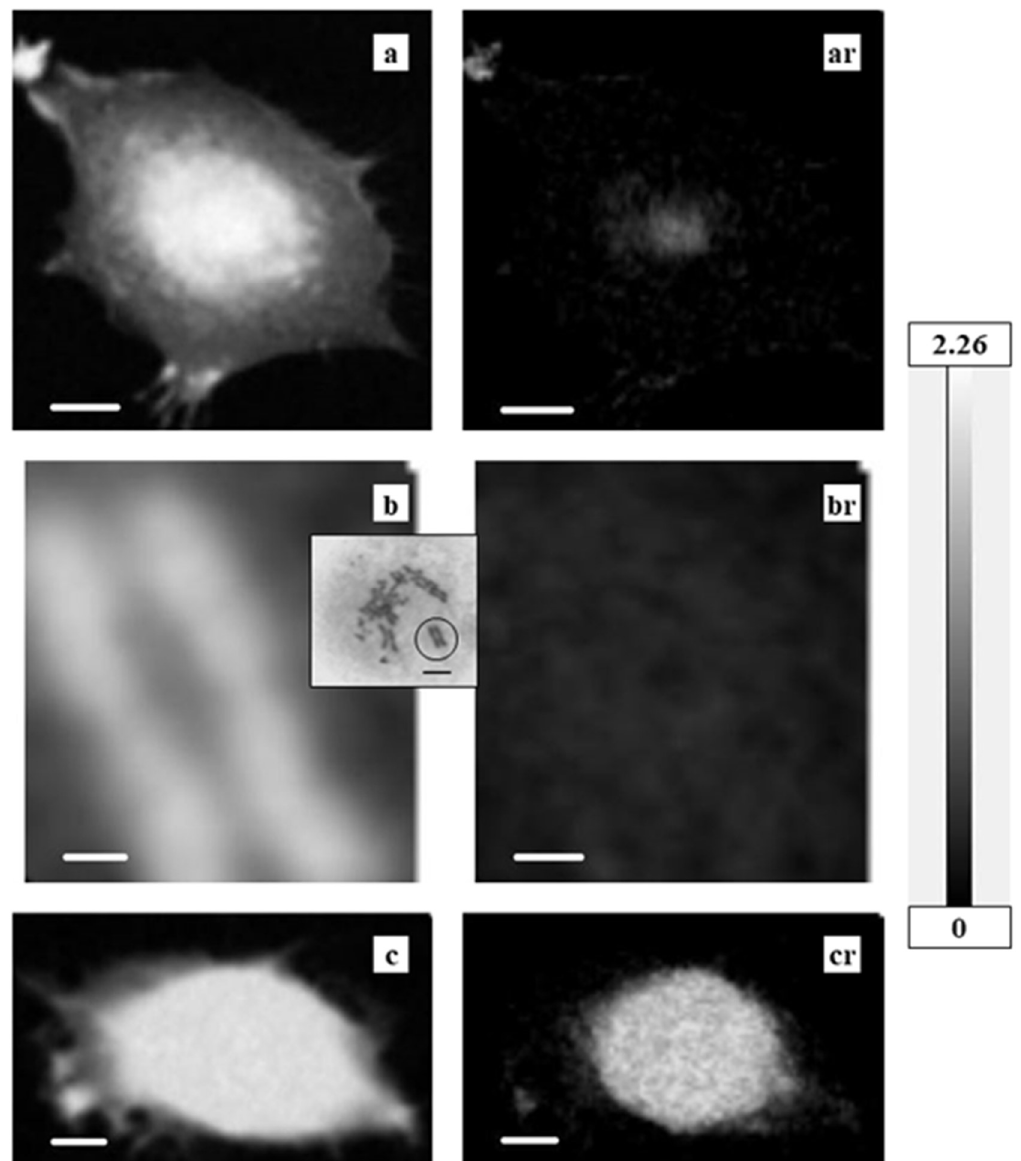
Figure 2. Absorption images on the left (spect1), with residual images after subtraction of nucleic acids and proteins (spect3) on the right. ( a , ar ) CHO cell; ( b , br ) chromosome—location indicated by circle in ( b inset ), which shows a CHO cell at M phase; ( c , cr ) HeLa S3 cell. All observed at 290 eV. Grayscale on the right indicates OD, which is consistent among these images to allow for comparison of observed and residual images. Scale bars represent 5 μm ( a , ar ), 0.5 μm ( b , br ), and 2 μm ( c , cr ).